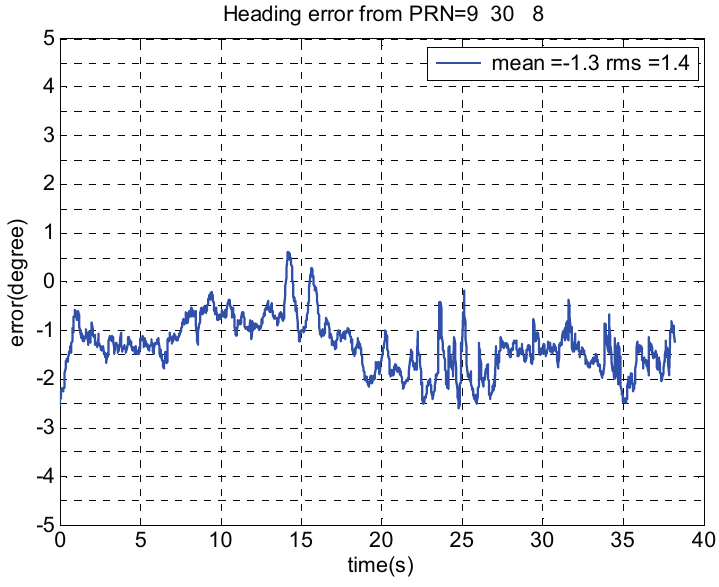
Figure 9. Error in heading angles obtained from PRNs 9, 30 and